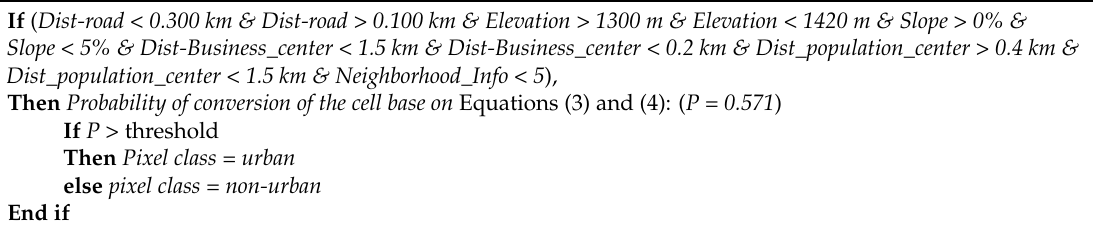
Figure 6. The proposed model for urban growth modeling by the ABC-CA, PSO-CA, and CA-logistic models. Table 2. Part of the transition rules derived by using the proposed models. Table 2. Part of the transition rules derived by using the proposed